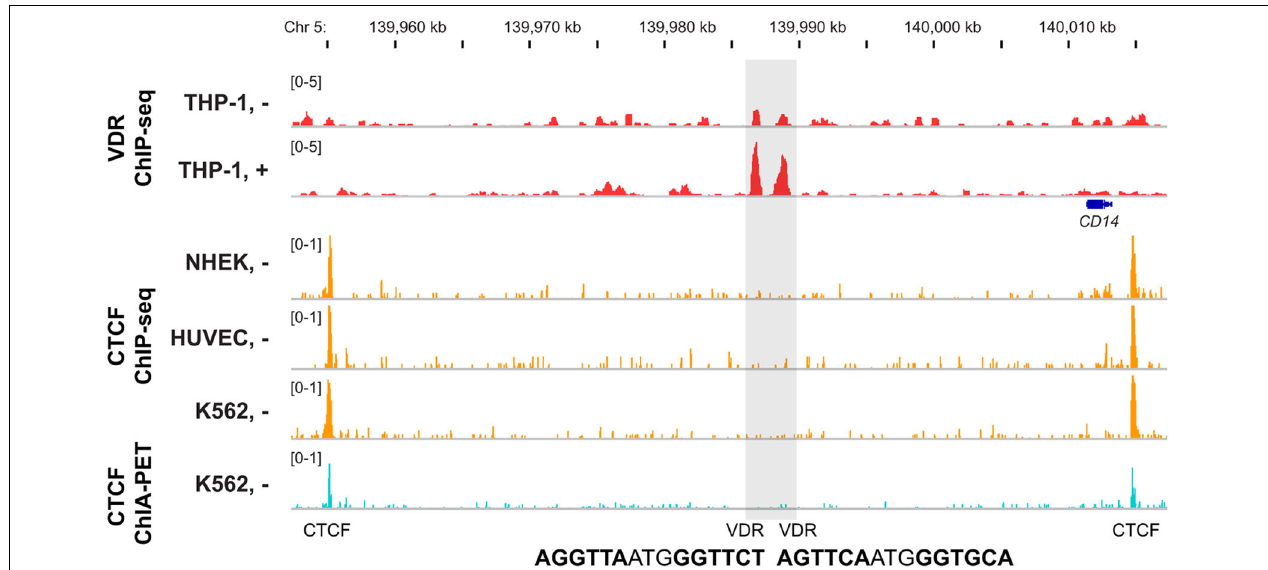
FIGURE 3 | Chromatin domain containing VDR binding sites. The IGV browser was used to display the chromatin domain around the CD14 gene. VDR ChIP-seq data from THP-1 cells [unstimulated ( − ) and treated for 40min with 1,25(OH) 2 D 3 ( + ), red] are shown in comparison with CTCF ChIP-seq